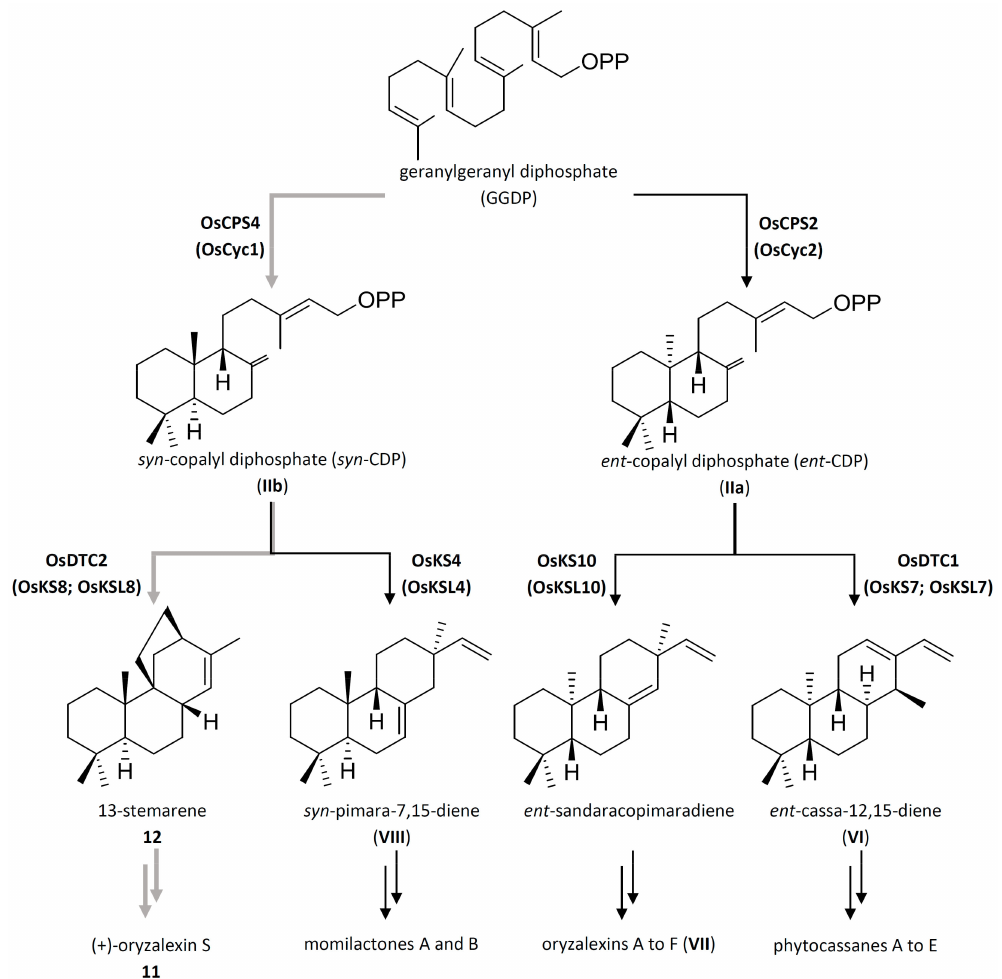
Scheme 2. Proposed pathway for the biosynthesis of diterpenoid phytoalexins in rice. Grey arrows indicate the branch that leads to ( + )-oryzalexin S 11 , while black arrows indicate the branches that leads to other labdane-related diterpenoids OsCPS2 (OsCyc2): ent -copalyl diphosphate synthase 2; OsCPS4 (OsCyc1) syn -copalyl diphosphate synthase; OsDTC1 (OsKSL7; OsKS7): ent -cassa-12,15-diene